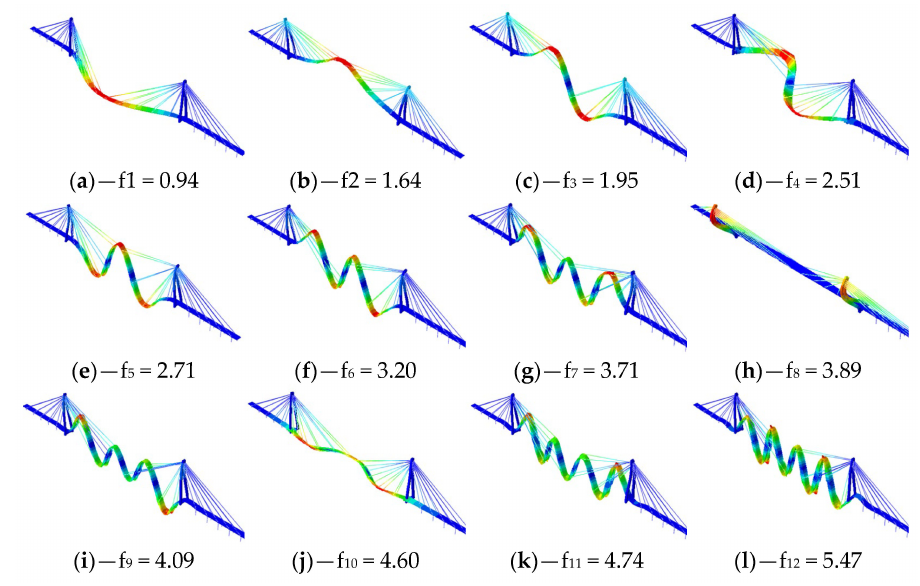
Figure 11. The numerical simulations: the mode shapes and frequencies [Hz] (the color spectrum that was adopted for the orthonormalized vectors—red expresses the maximum value and blue expresses the minimum value).